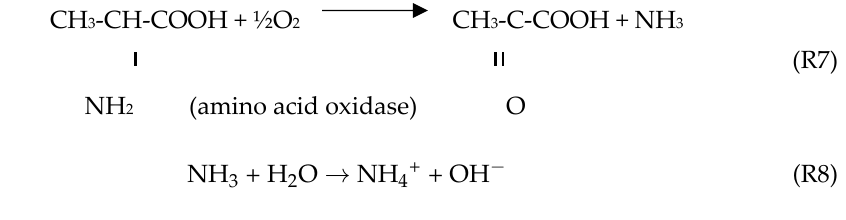
Table 2. Soil pH, KCl-extractable Al, and NaHCO 3 -extractable P in an acid Oxisol as affected by lime, rock phosphate and green manure